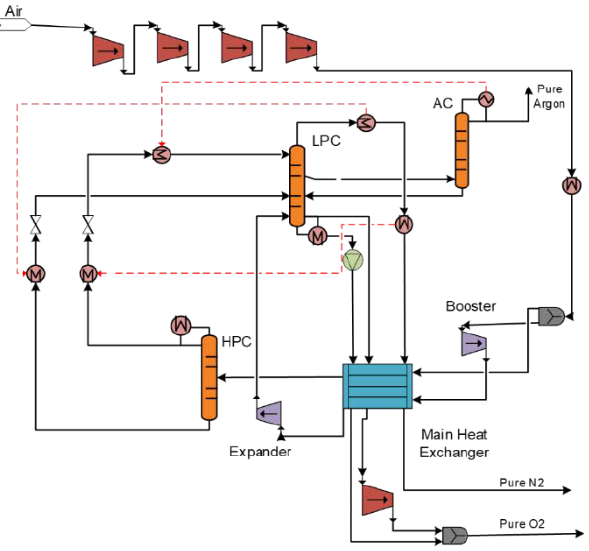
Figure 3. Air separation unit flow diagram .